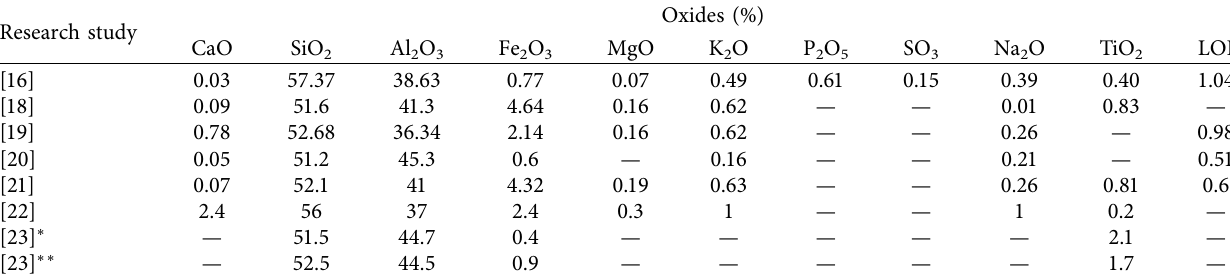
Table 3: Chemical composition of MK samples used in past research studies.